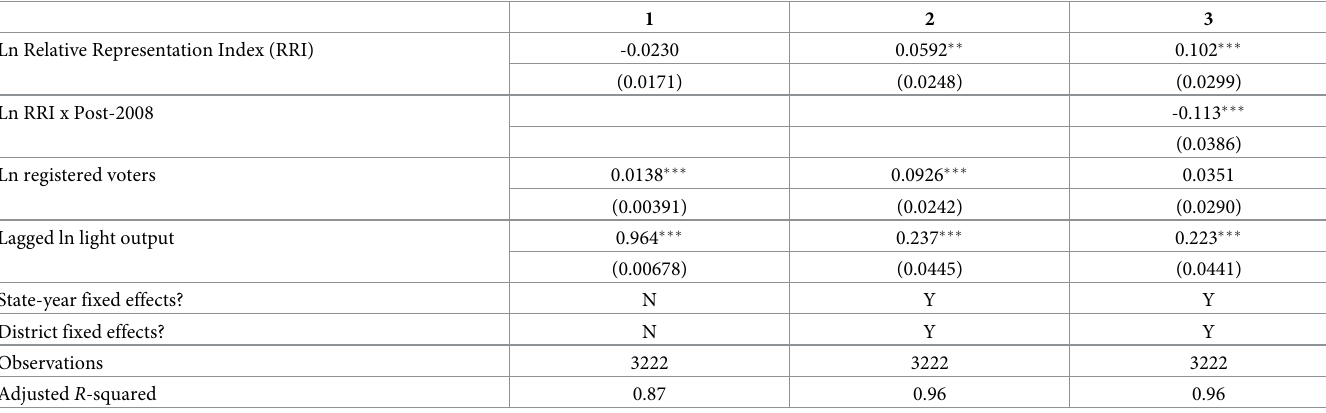
Table 1. Does malapportionment affect light